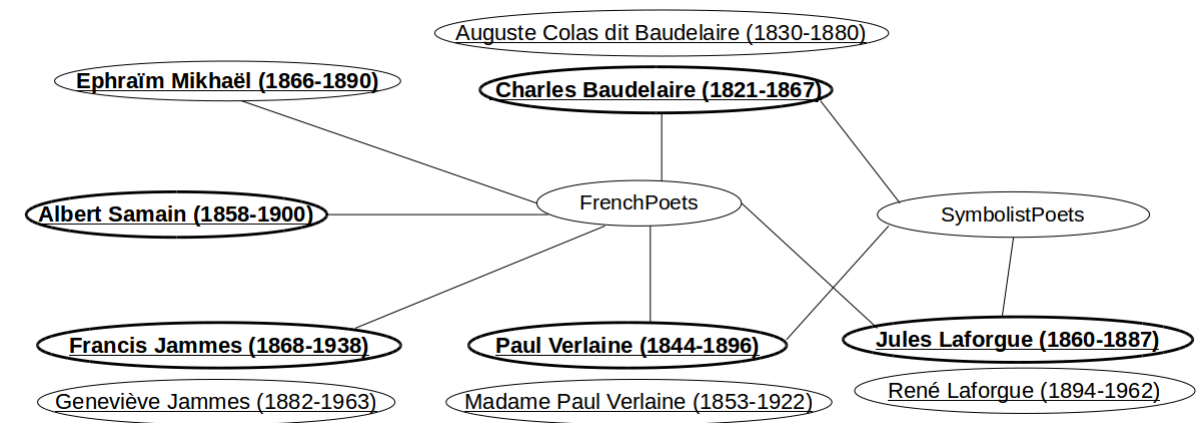
Figure 1. Excerpt of the chosen URIs (in bold) for the six candidates (underlined); here, all edges represent rdf:type